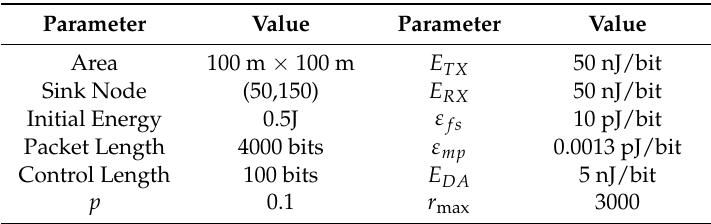
Table 4. Experimental Parameters.